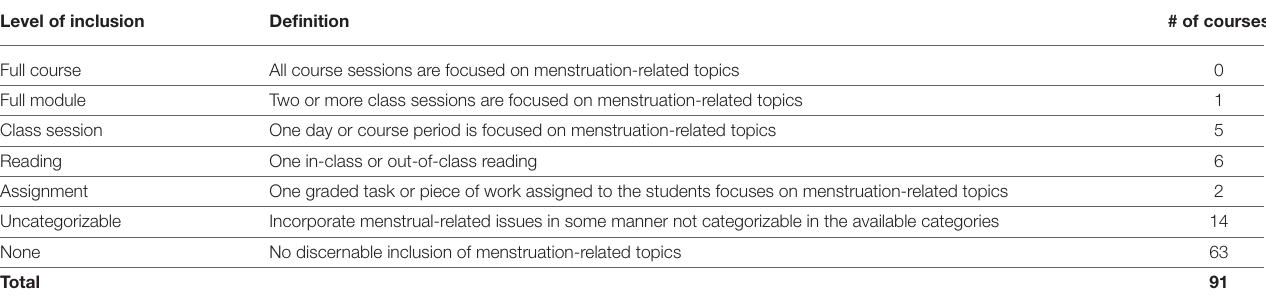
TABLE 1 | Level of Inclusion of menstruation-related topics in public health